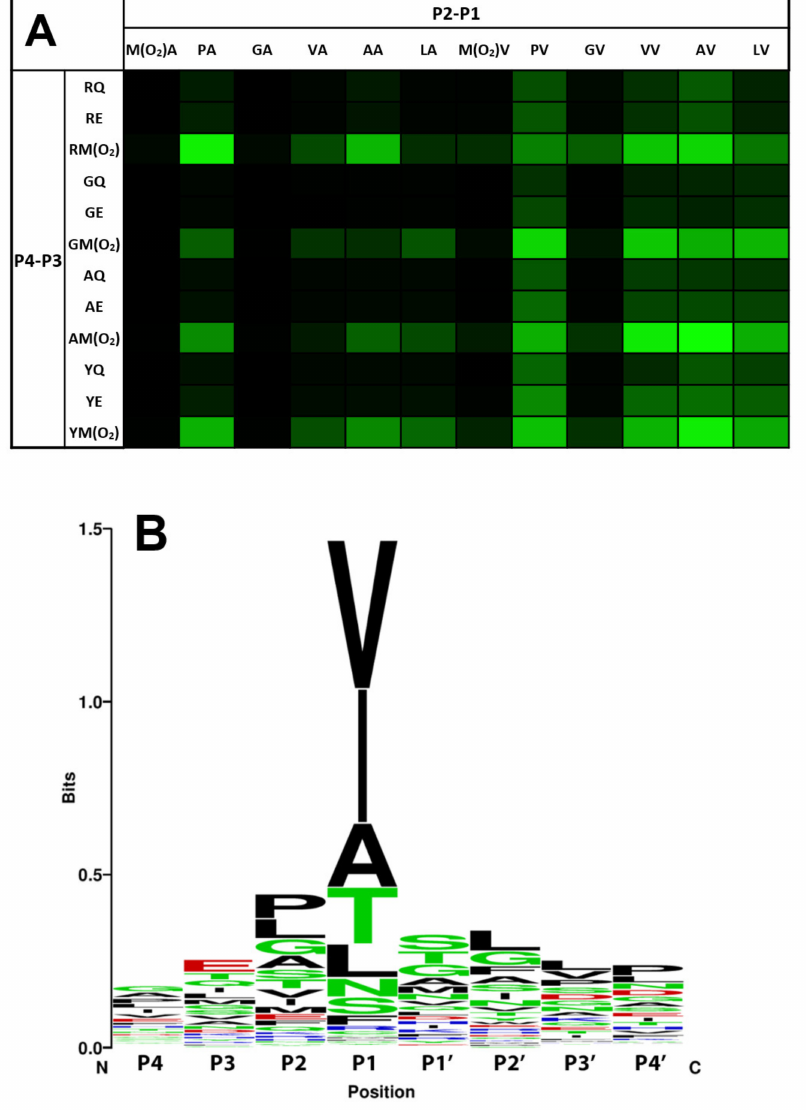
Figure 1. HNE substrate selectivity ( A ) heat map representation of tetra-peptide-pNA sparse matrix library screened for activity in HNE kinetic assays. Bright green cells represent peptides that showed high rates of HNE proteolysis, black cells represent peptides that showed no detectable HNE proteolysis. Each square represents the average rate from three replicate experiments of triplicate measurements. Final assay concentrations were 300 µ M peptide-pNA and 1 µ g/mL HNE. ( B ) HNE consensus sequence derived from the MEROPS database showing amino acid frequency distribution between positions P4 and P4 (cid:48) . Amino acids are coloured according to sidechain chemistry: black = non-polar; green = polar; red = negatively charged and blue = positively